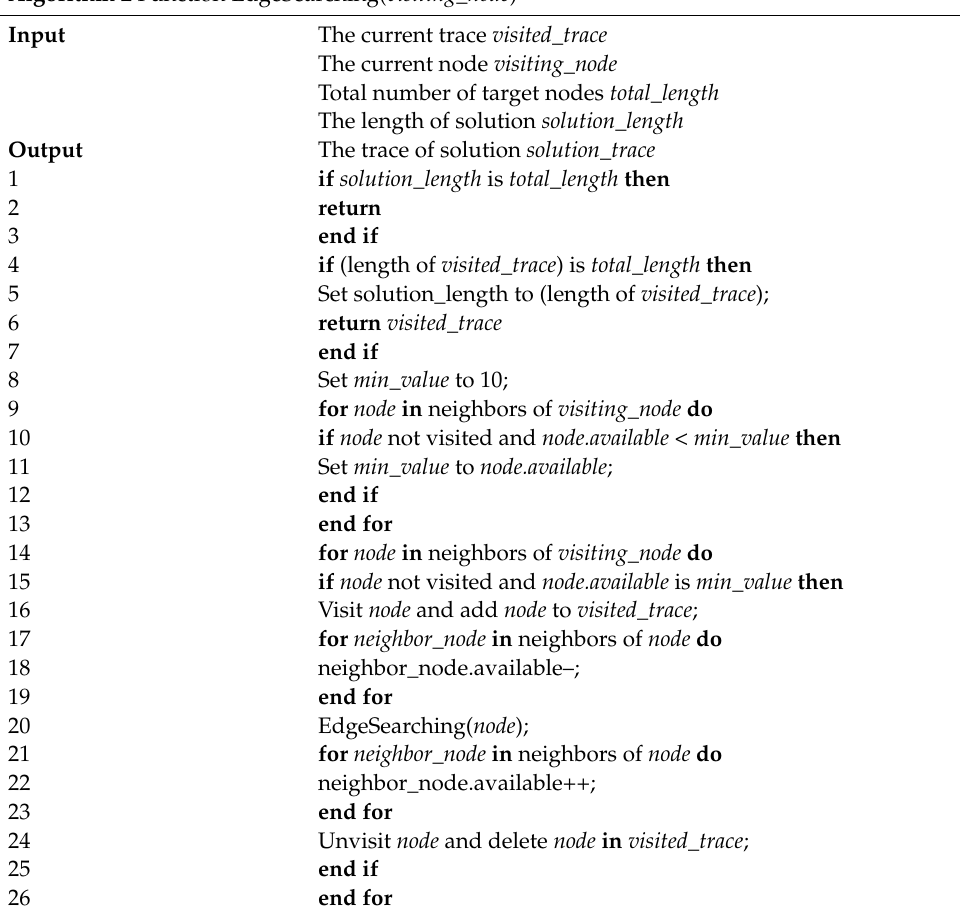
Algorithm 2 Function EdgeSearching( visiting_node